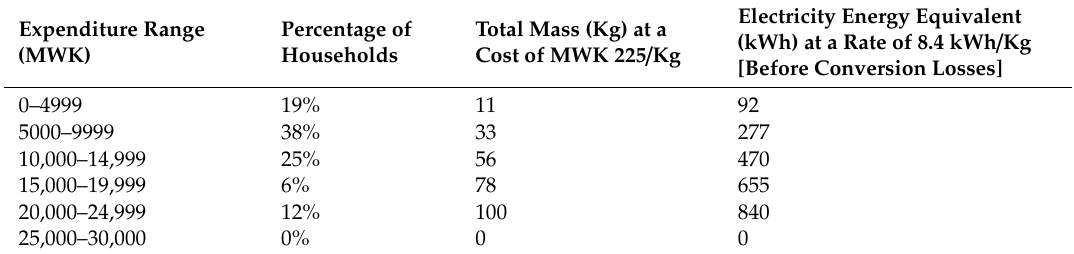
Table 4. Household monthly expenditure on charcoal and kWh